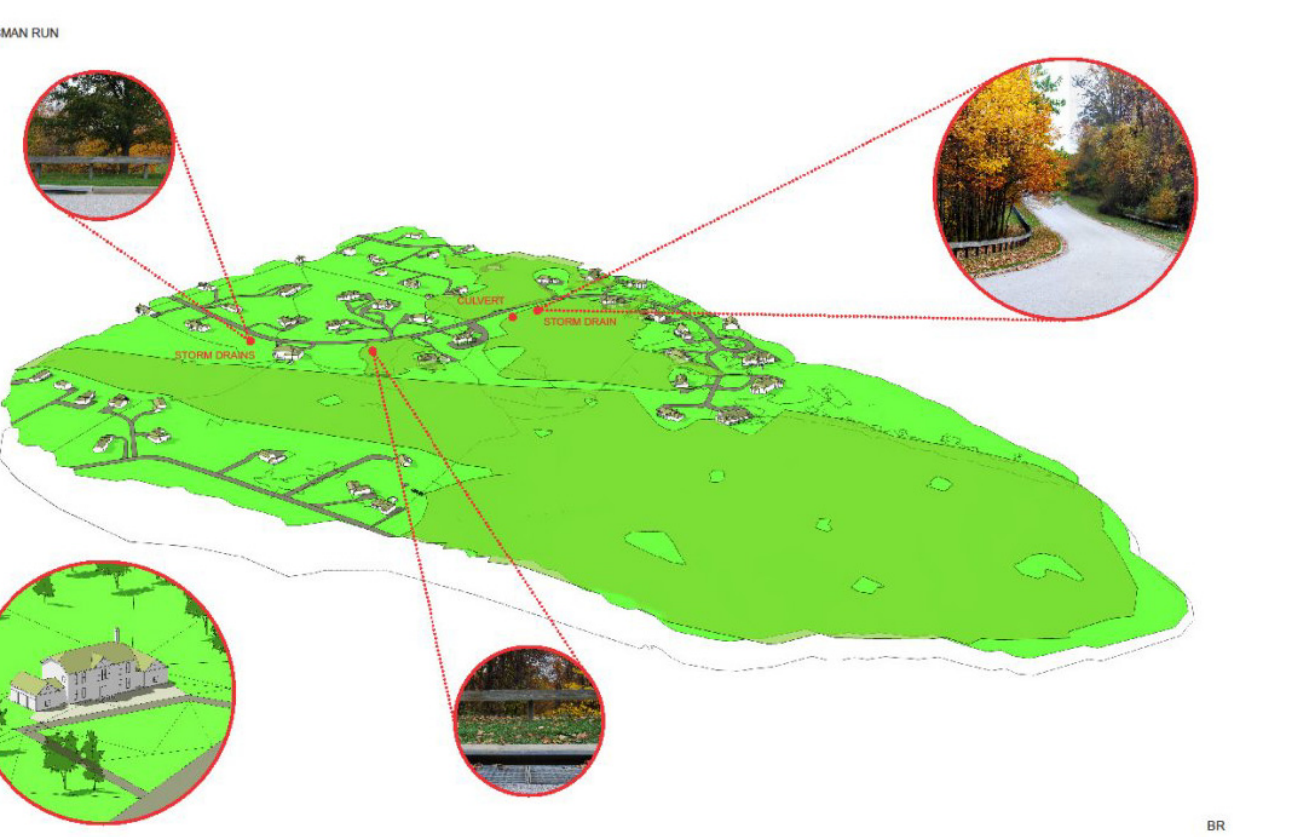
Figure 5. Baisman Run is a forested sub-catchment in Baltimore County where residential development is highly regulated to protect downstream drinking reservoirs. This outer periphery sub-catchment includes large houses on six-acre lots with septic systems built along wide winding cul-de-sacs set back from open streams. (Courtesy of